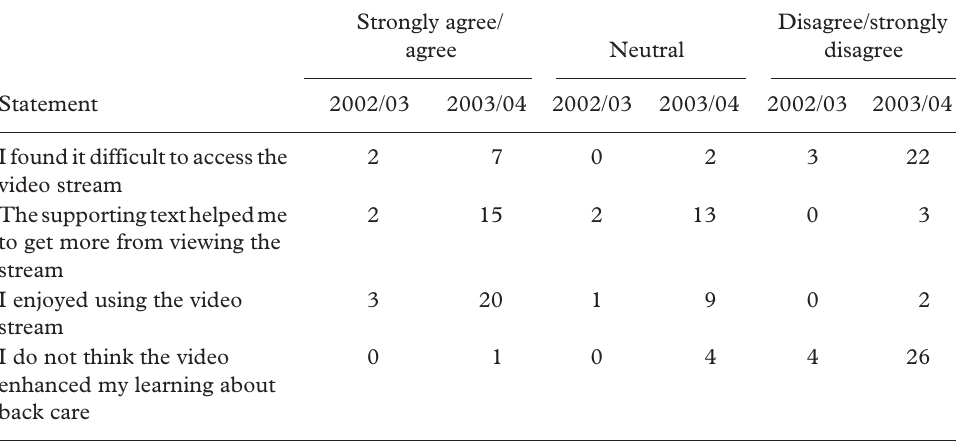
Table 2. Responses from those members of the 2002/03 and 2003/04 cohorts who had